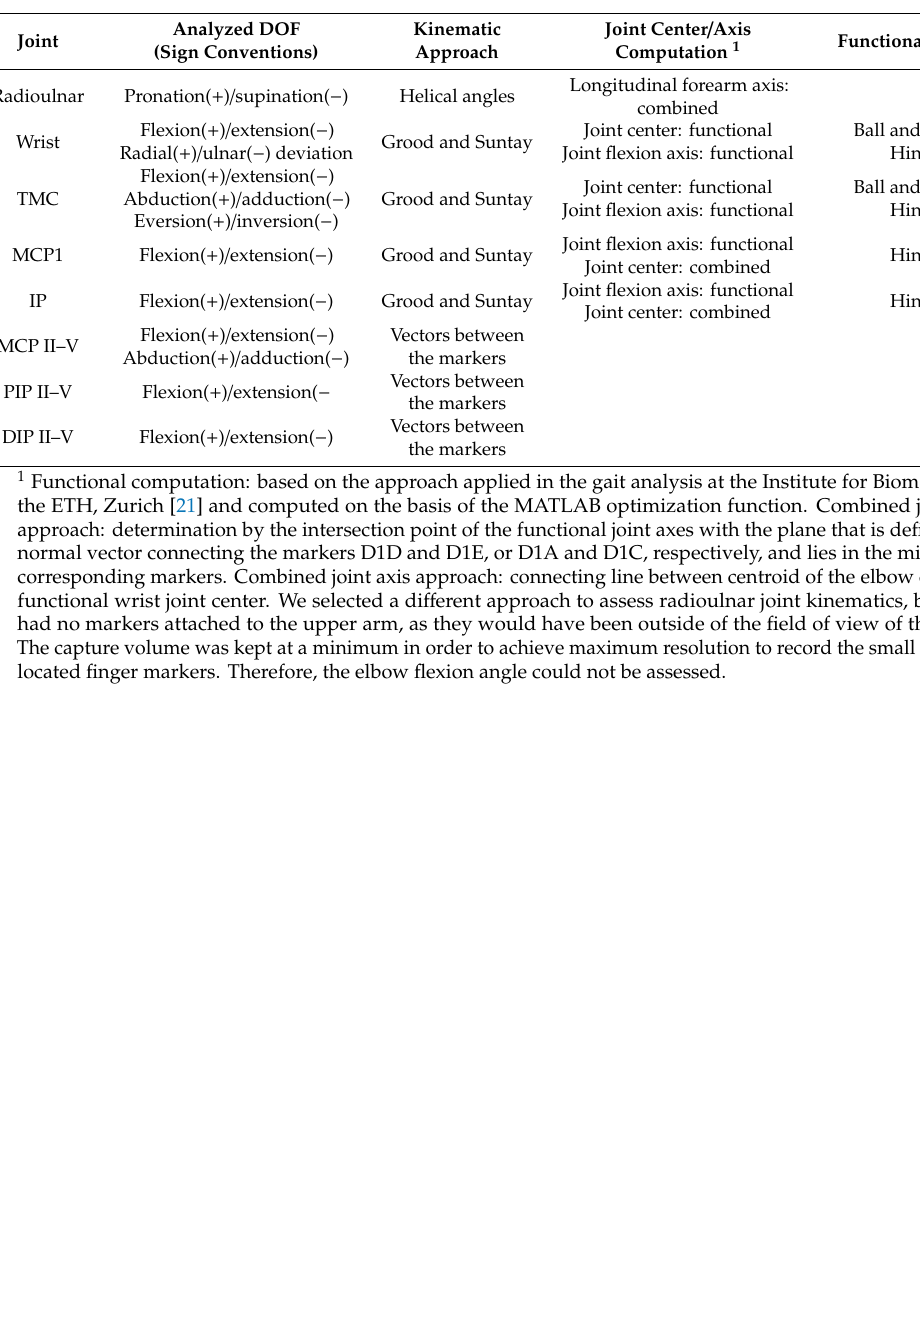
Table 2. Joints of Interest and Kinematic